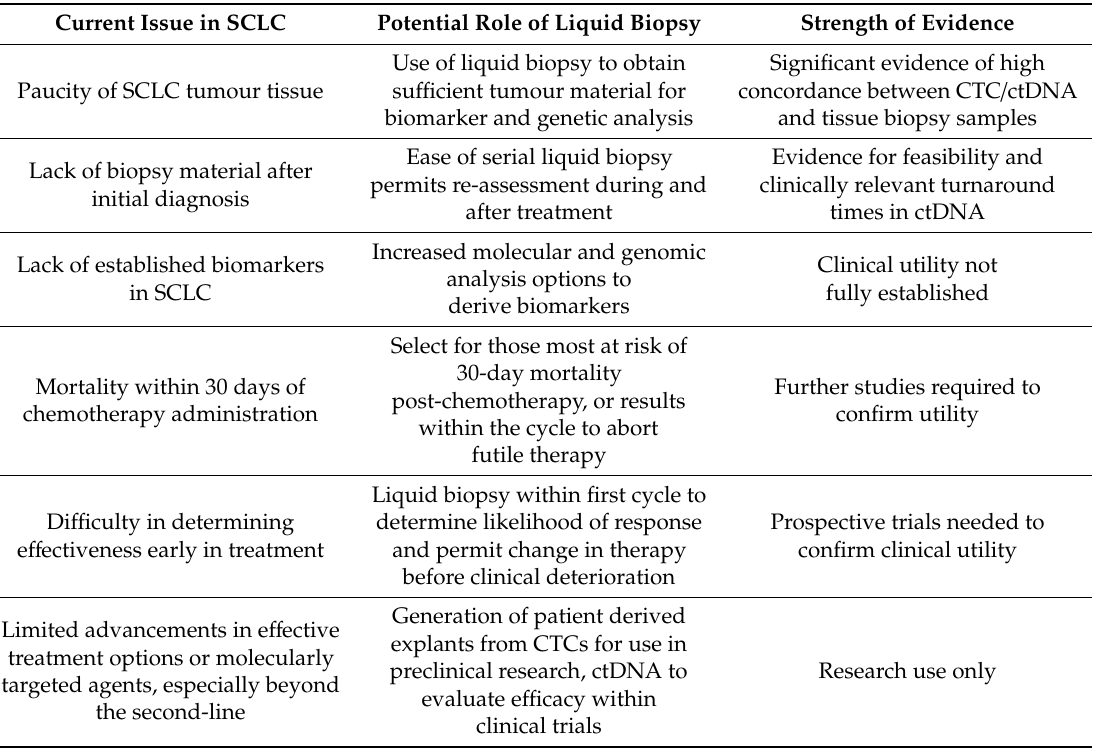
Table 1. Summary of current issues in SCLC which may be addressed by the use of liquid biopsy methods, and the current state of the evidence base for their